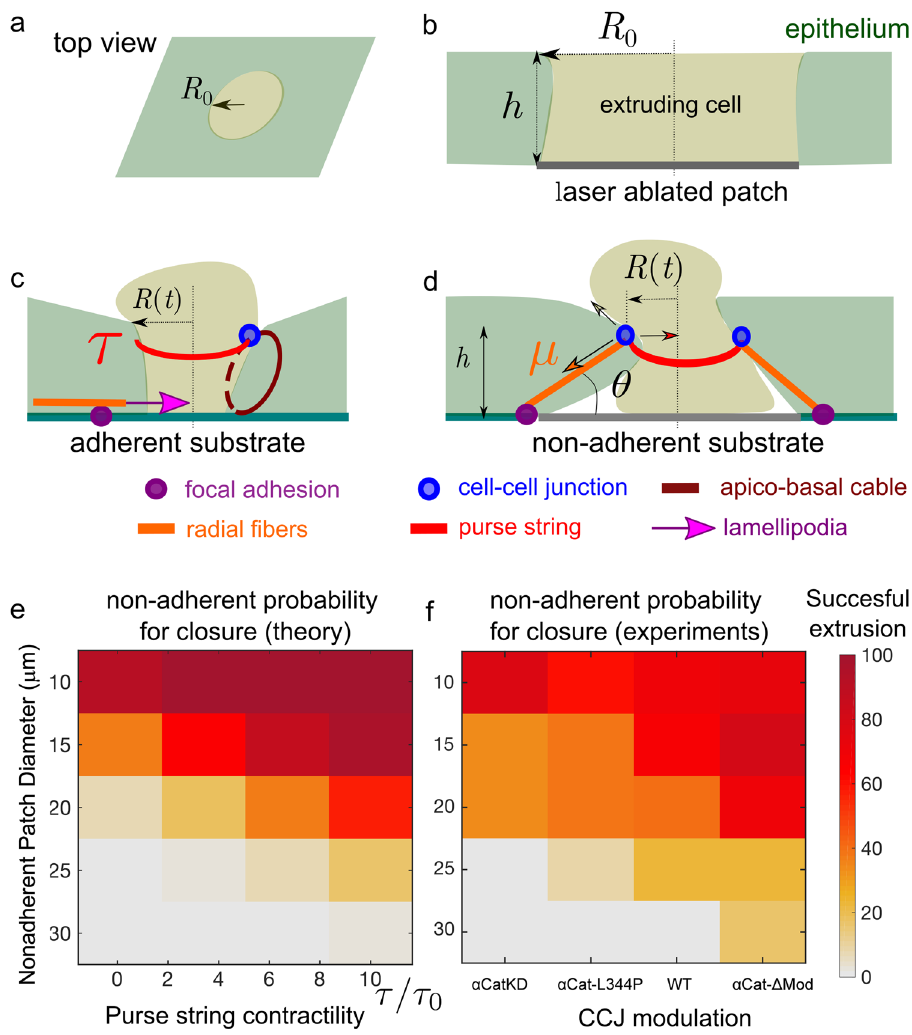
epithelium. b Side view at the initial stage of extrusion with the laser ablated patch (corresponding to one or several cells) of a radius R0. c Adherent case: a combination of lamellipodia, apico-basal cable, and nonuniform purse-string contribute to the extrusion process. d Nonadhesive case: a multicellular purse- string of tension τ (red circle) contributes to the extrusion dynamics while apico-basal cables (orange line), with a tension denoted μ , provide a